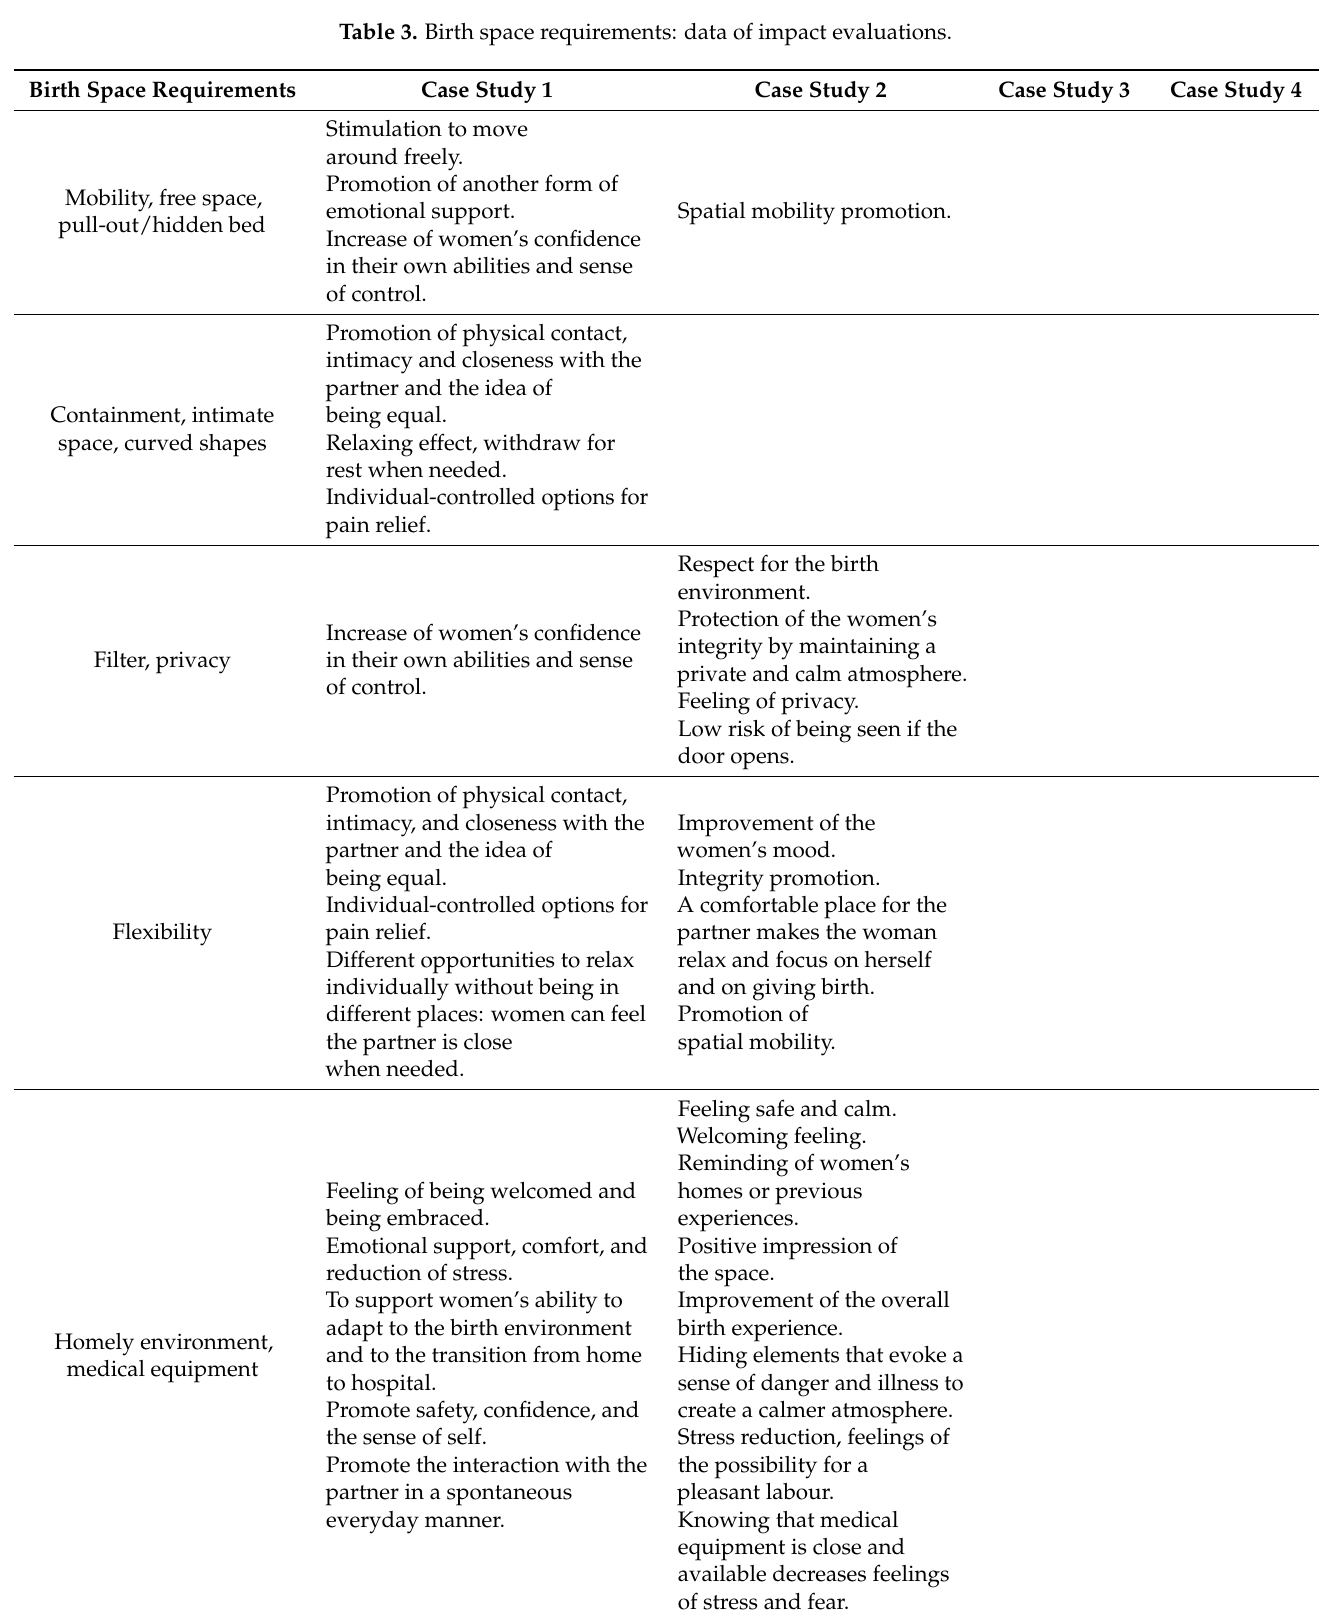
Table 3. Birth space requirements: data of impact